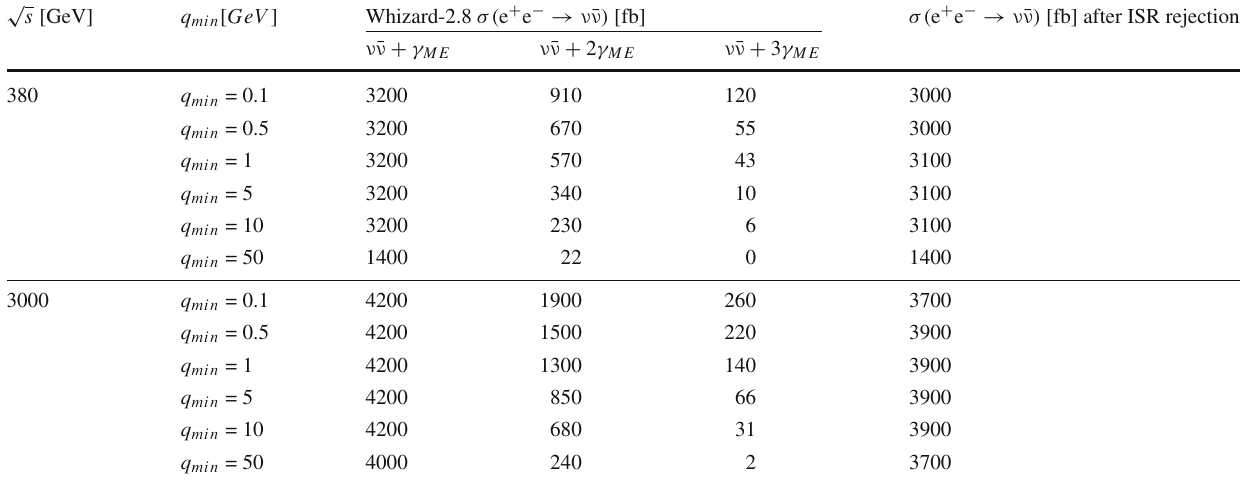
Table4 Crosssectionvaluesfordifferentmergingparameter q min anddifferentmultiplicitiesofphotonsincludedinthematrixelementcalculations in (radiative) ν ¯ ν events with the ’hard photon’ requirement. Number of significant digits indicates the statistical precision resulting from Whizard integration